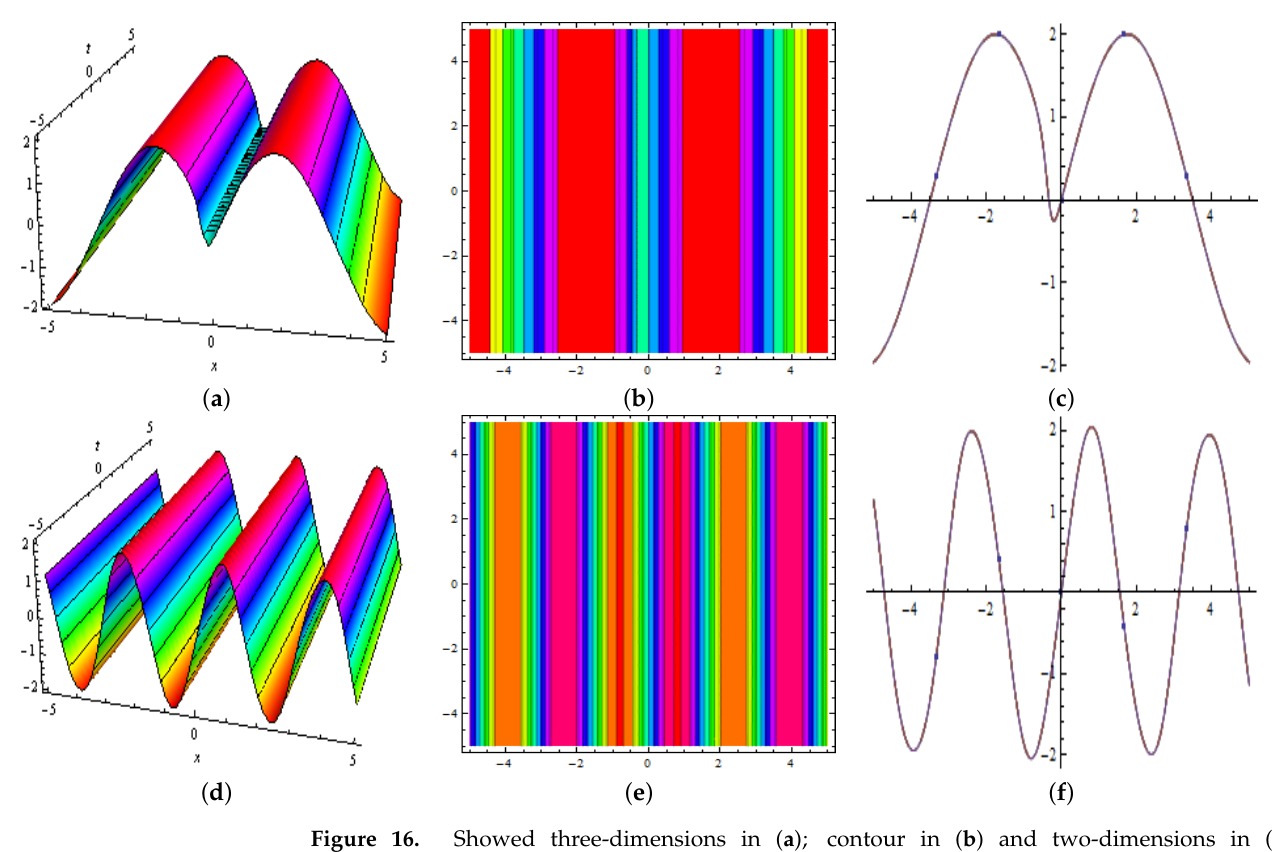
Figure 16. Showed three-dimensions in ( a ); contour in ( b ) and two-dimensions in ( c ), Graphical representation of m 63 ( x , t ) in Equation (62), for b 2 = − 5, b 3 = 1, b 6 = 5,